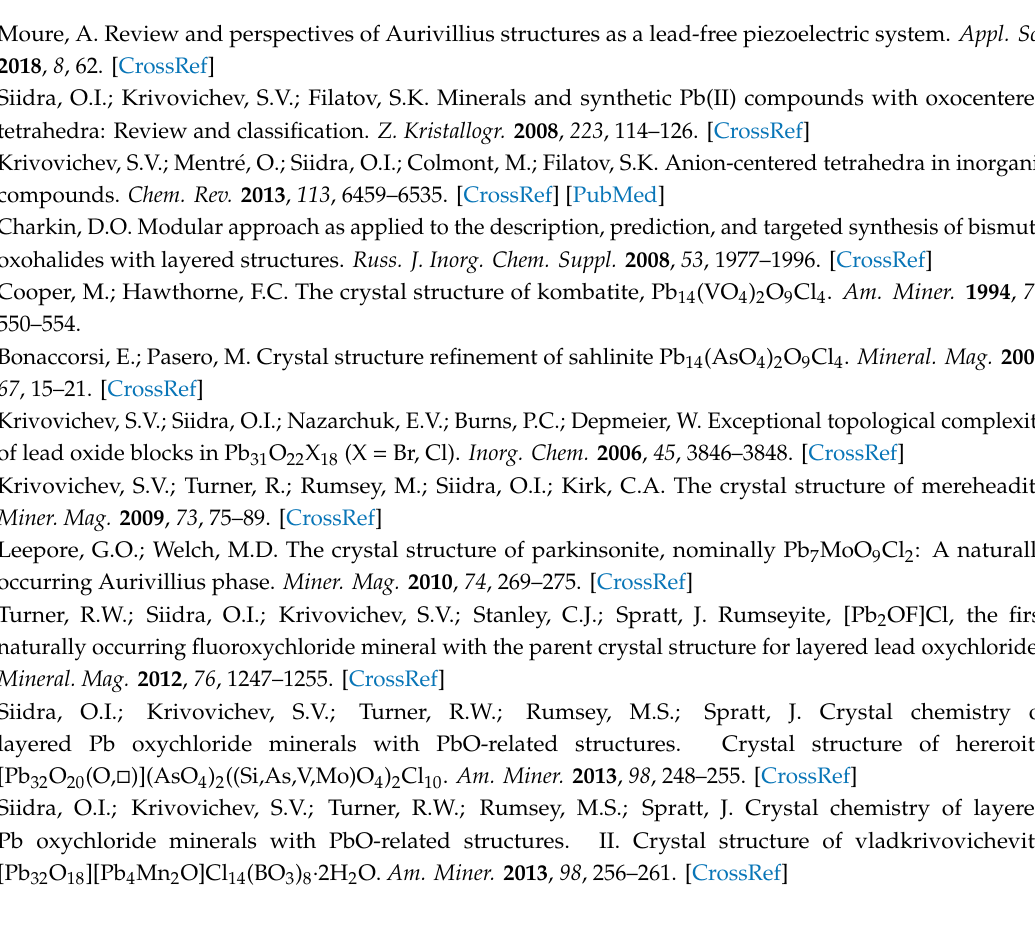
Figure S1. Rietveld refinement plots for [Ho 2 O 2 ]SO 4 and [Dy 2 O 2 ]SO 4 . Table S1. Coordinates and isotropic displacement parameters (Å 2 ) of atoms in [Bi 2 CuO 3 ](SO 4 ). Table S2. Anisotropic displacement parameters (Å 2 ) of atoms in [Bi 2 CuO 3 ](SO 4 ). Table S3. Coordinates and isotropic displacement parameters (Å 2 ) of atoms